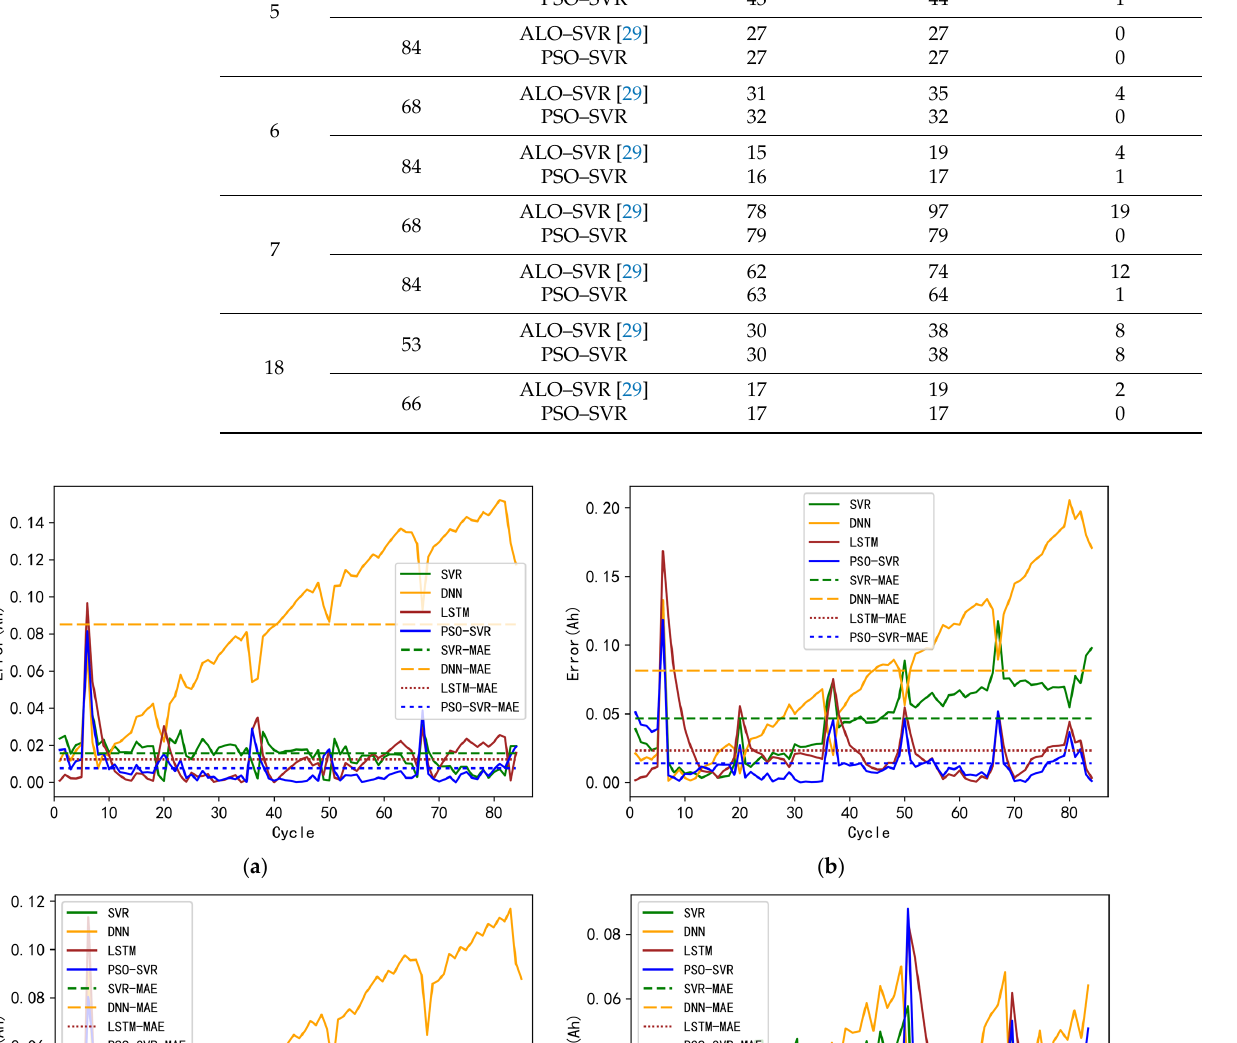
Figure 9. Absolute error and mean absolute error based on SVR, DNN, LSTM and PSO–SVR using the first 50% of the total cycle data for training: ( a ) B5; ( b ) B6; ( c ) B7; ( d )